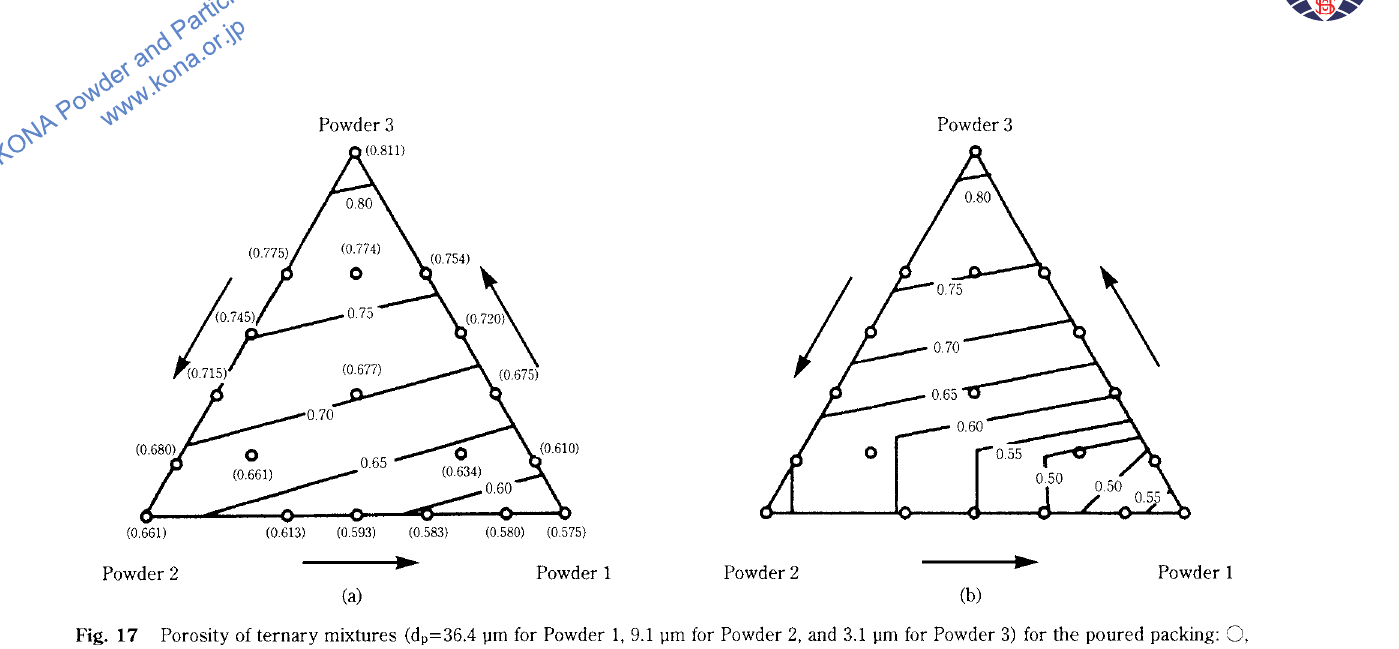
Fig. 17 Porosity of ternary mixtures (dp=36.4 pm for Powder 1, 9.1 pm for Powder 2, and 3.1 pm for Powder 3) for the poured packing: CJ, measured;-, predicted by use of: (a), r;i; and (b), R;j.